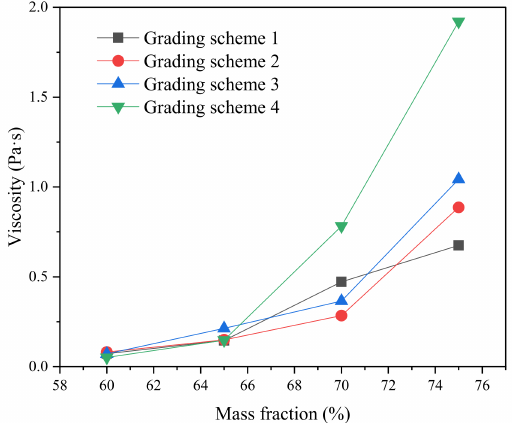
Figure 6. Effect of mass fraction on plastic